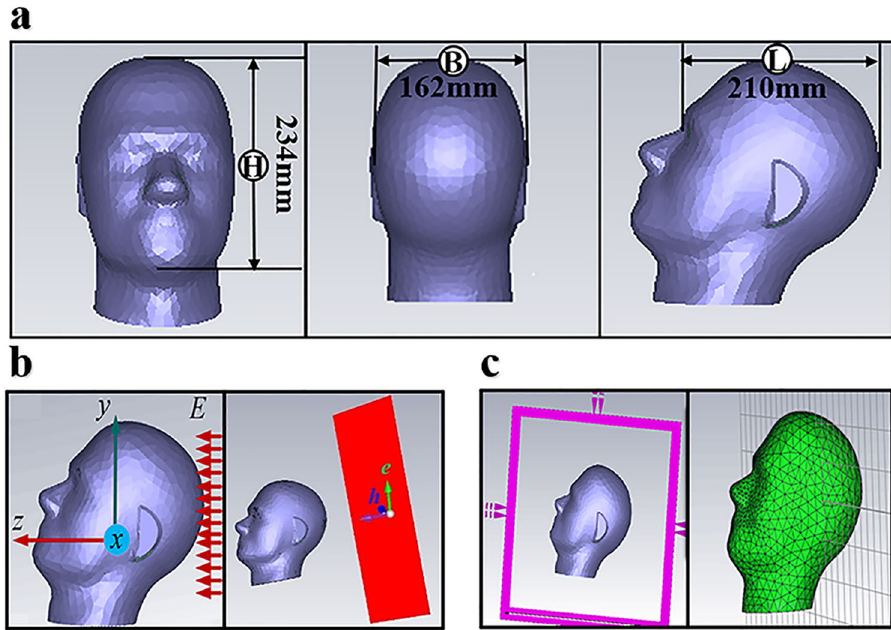
Figure 1. The SAM model and simulation scene. (a) Outer shape and size of the SAM model, (b) coordinate system definition and the incident wave, (c) simulation region and structure